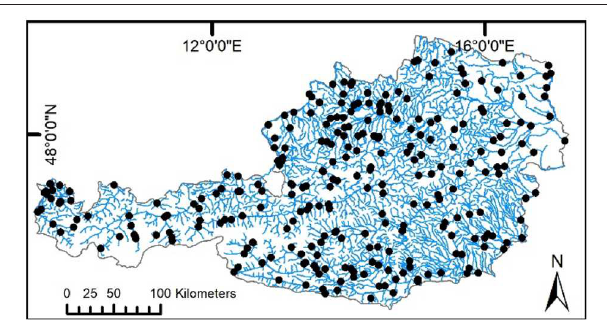
FIGURE 1 | Location of the 274 Austrian river gauging stations (black dots) and the river network (blue lines) included in the water temperature